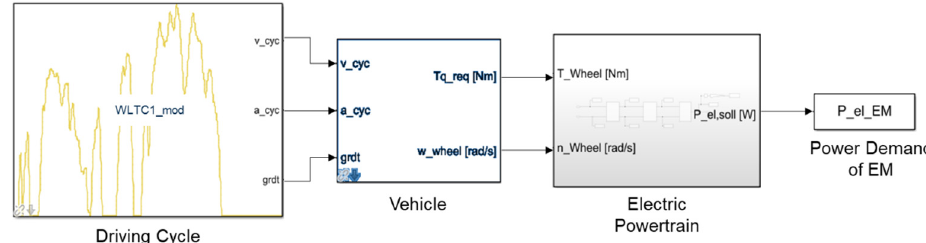
Figure 2. Overview of the simulation model.